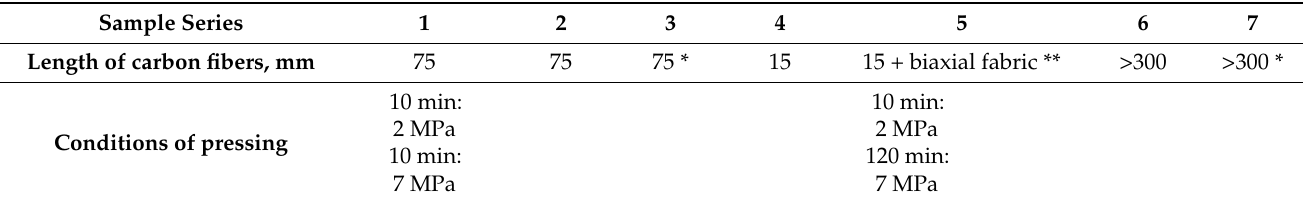
Table 1. Description of CFRP composite panel (300 × 200 mm) series used in the